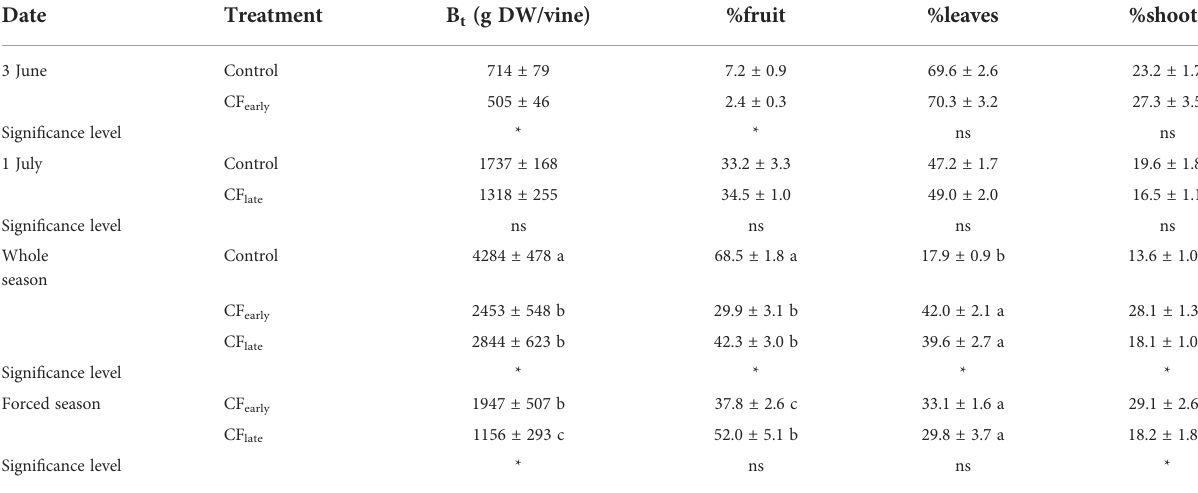
TABLE 4 Biomass removed and distribution on forcing dates and at the end of the season in year